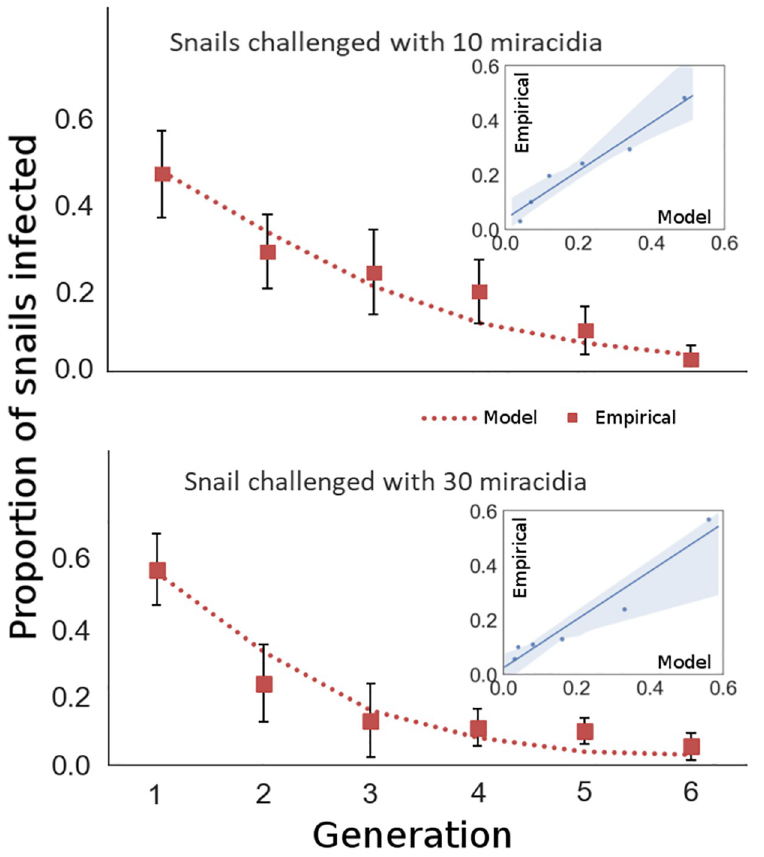
Fig 2. Comparison of model results to empirical data from published selection experiments by Tennessen et al. 2015. Two selection experiments were conducted, the first challenging each snail with 10 miracidia (top, R 2 = 0.944), and the second challenging each snail with 30 miracidia (bottom, R 2 = 0.937). 95% confidence bars are displayed for each empirical measurement. Given initial conditions similar to experimental conditions, both models perform well in recapitulating selection for immunity to